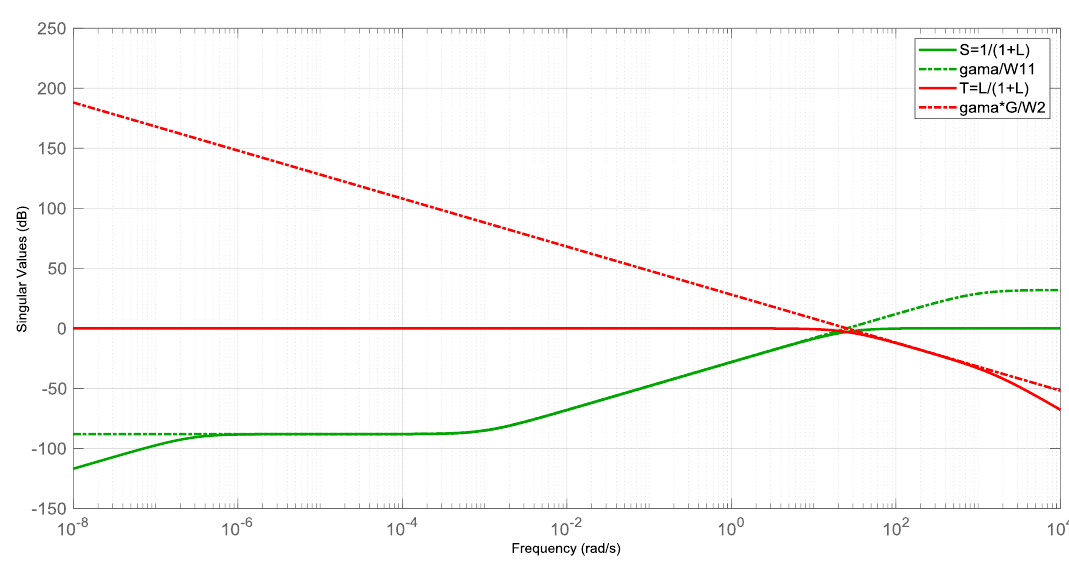
Figure 102. Singular value of functions S,